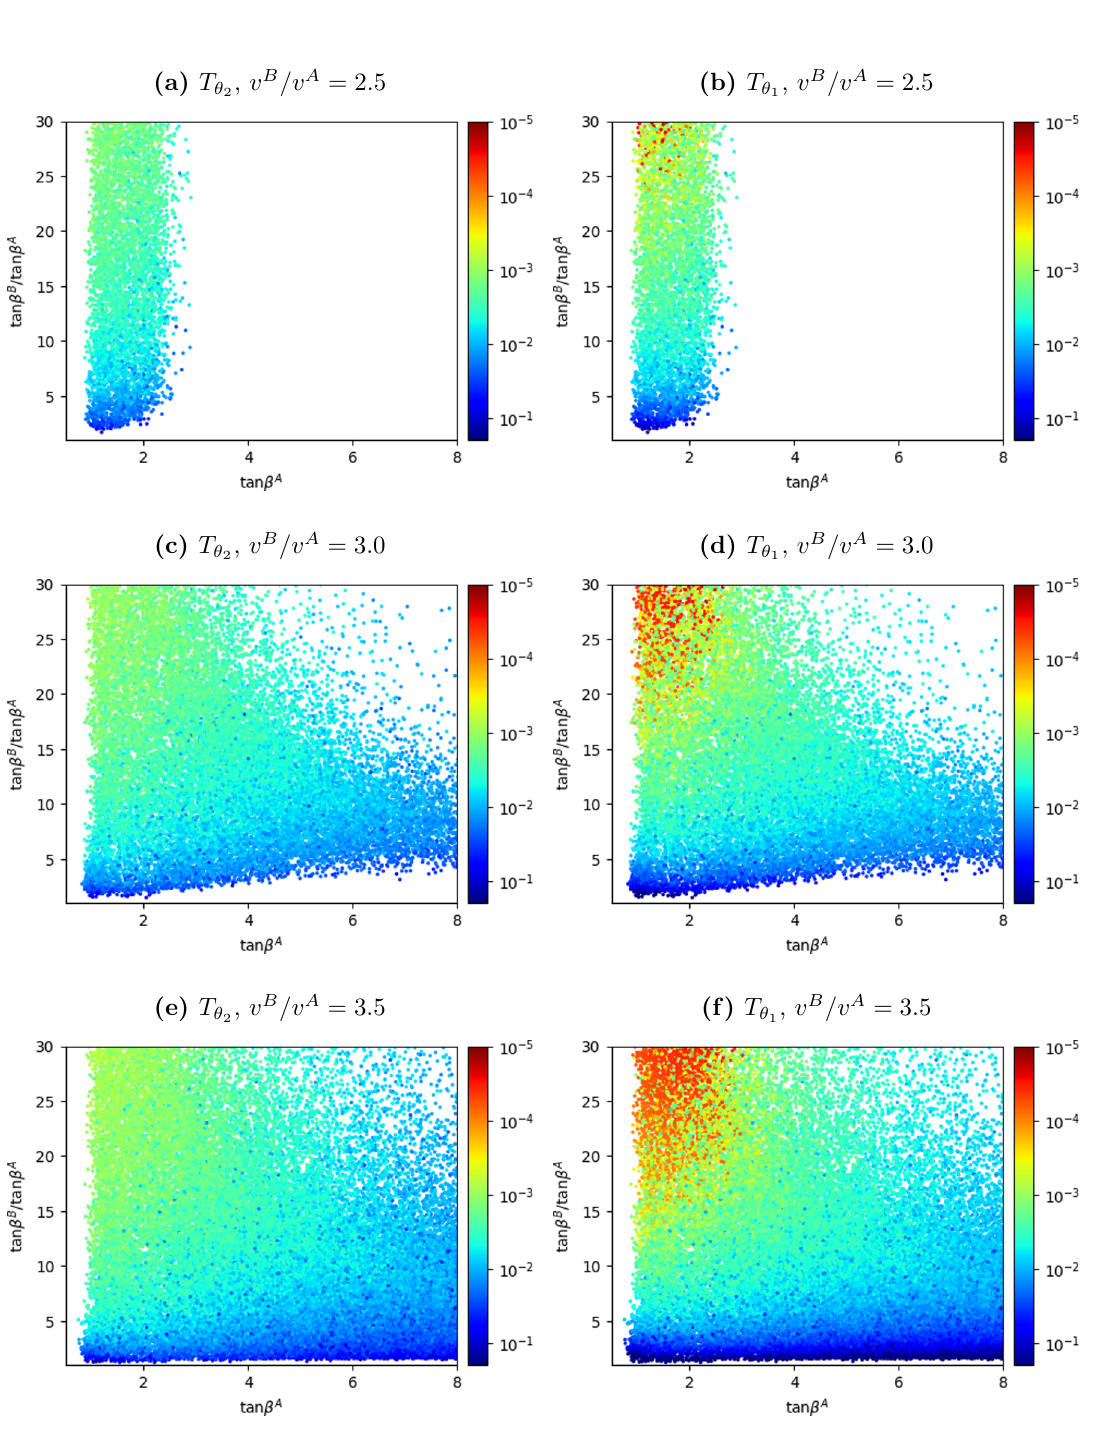
Figure 1. Values of tan (cid:12) A and tan (cid:12) B = tan (cid:12) A of the unexcluded points for di(cid:11)erent (cid:12)xed v B =v A and Type II. The colour corresponds to T (cid:18)